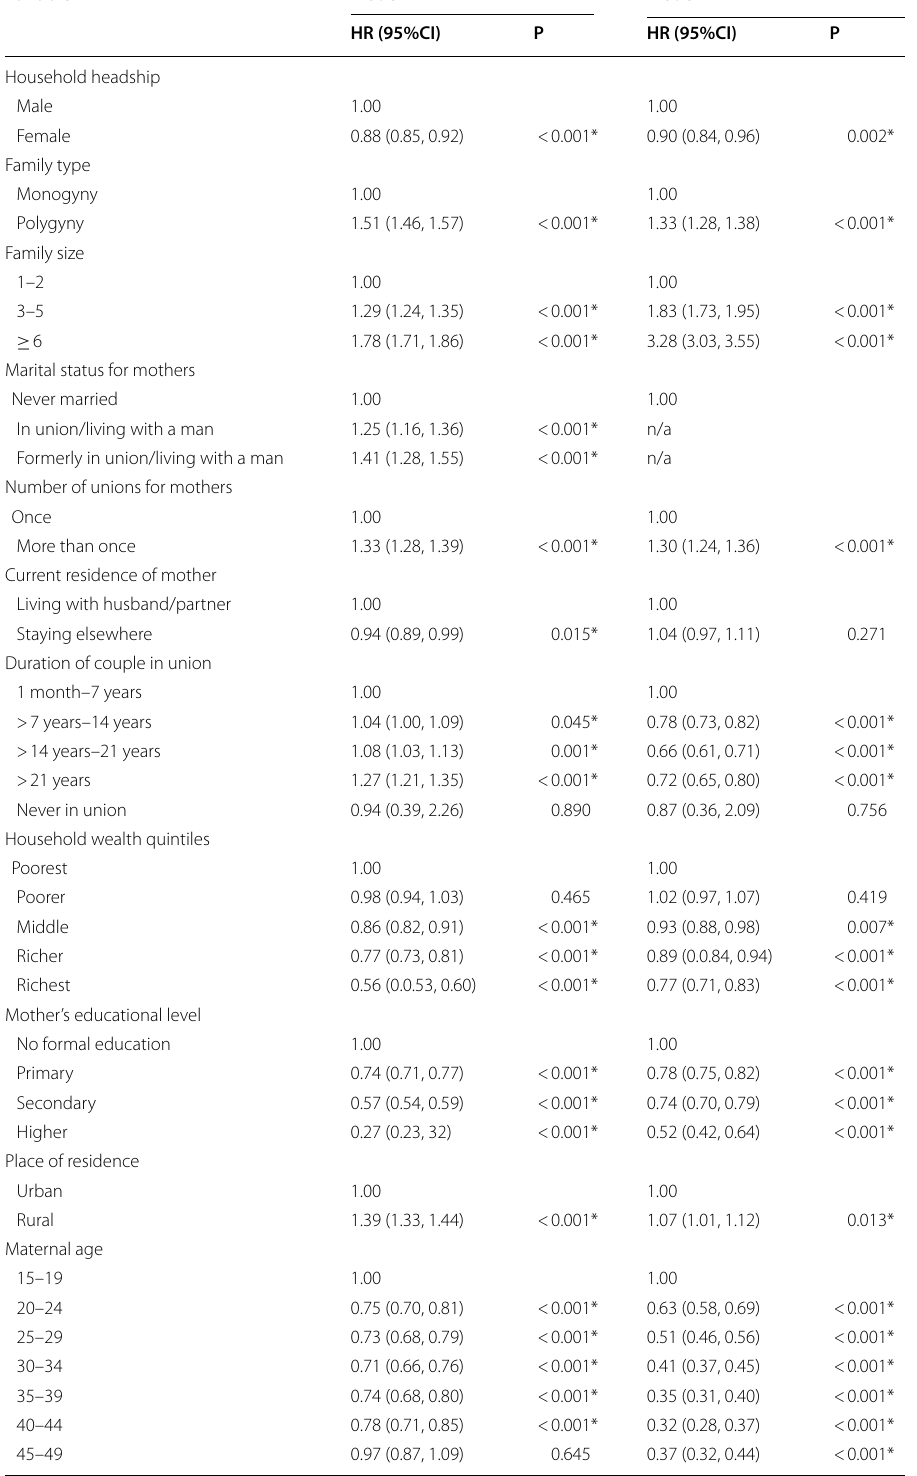
Table 4 Household factors associated with under-five mortality in SSA; DHS 2008–2017